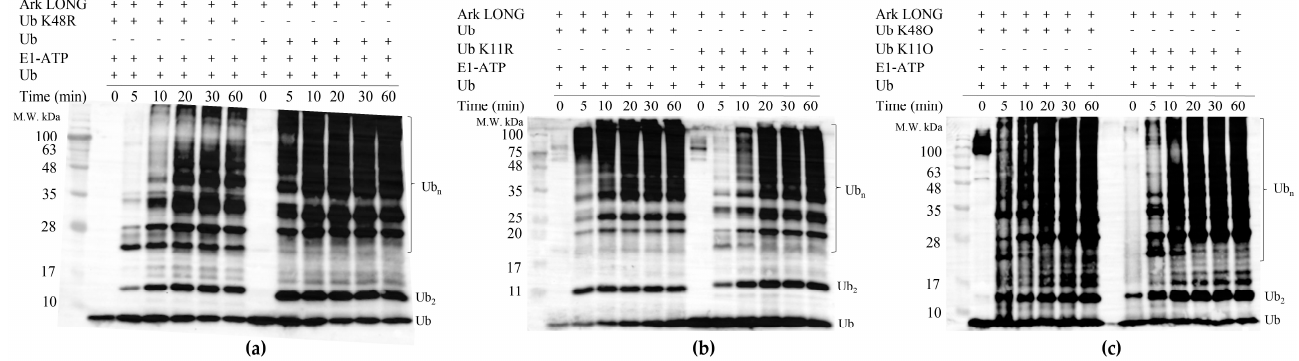
Figure 8. In vitro ubiquitylation assays using UbcH5B in the presence of ( a ) Ub K48R and wt Ub, ( b ) Ub K11R and wt Ub, and ( c ) Ub K48O and Ub K11O. ( b ) Ub K11R and wt Ub, and ( c ) Ub K48O and Ub